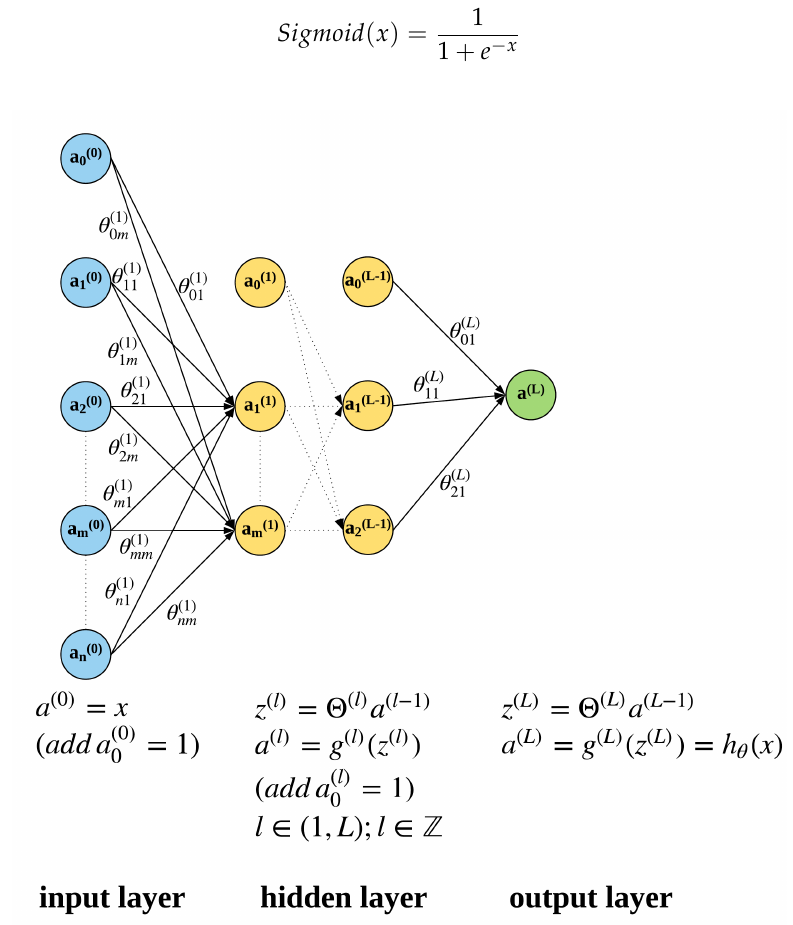
Figure 2. Three layers of ANN: input (blue); hidden (yellow) and output (green) layers. ’ a ’s are the values of each cell (the round boxes in the figure). The superscript of ’a’ represents the index of the ( l ) layer and the subscript of ’a’ represents the index of the cell in that specific layer. ’ a ’s denote the bias 0 units in each layer (’ l ’ is the index of the layer). Θ ( l ) is the cluster of all ’ θ ’s on the linkage between the ( l − 1 ) th layer and l th layer, and θ ( l ) ( l − 1 ) th nm means that is the coefficient between the n th cell in the layer and the m th cell in the l th layer. x and h θ ( x ) are the input and output of the system respectively. In addition, g ( l ) is the activation function for the l th